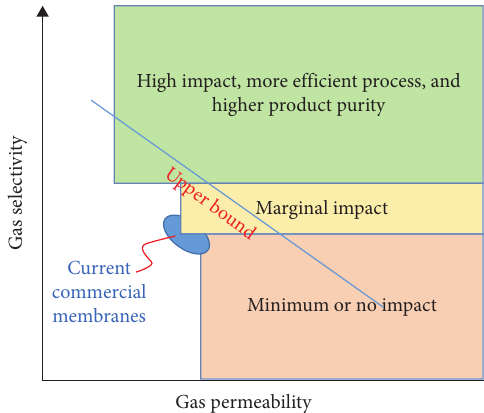
Figure 3: Relationship between membrane gas separation selec- tivity and permeability